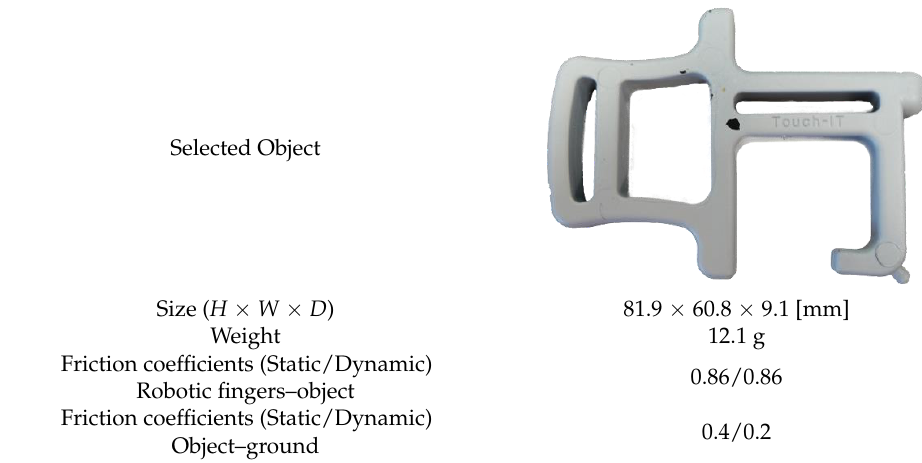
Table 3. The test object. Source: own.